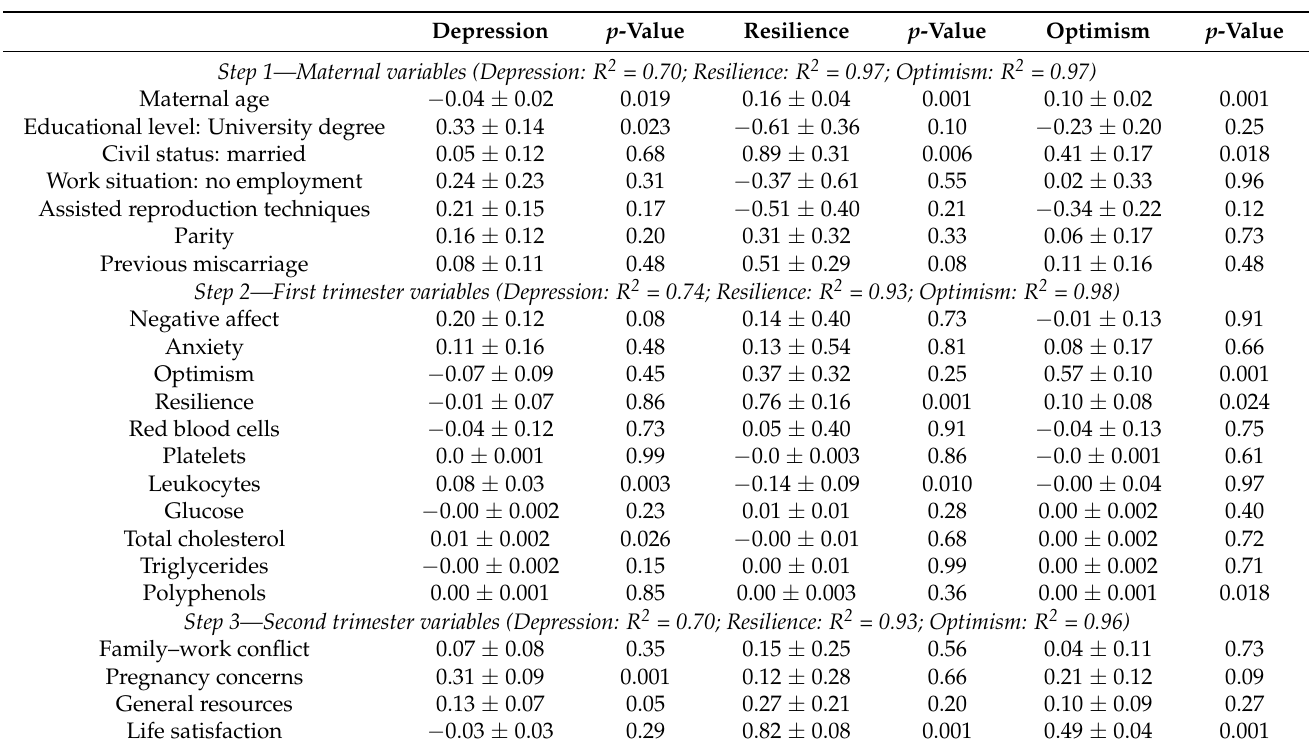
Table 3. Lineal regression analysis for depression, resilience, and optimism, as dependent variables, at the end of pregnancy. Depression p -Value Resilience p -Value Optimism p -Value